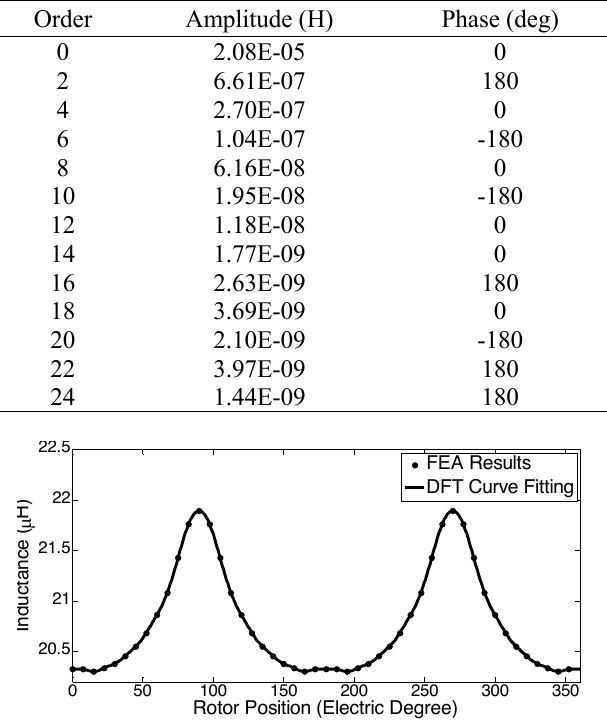
Table 6: Harmonics of Self Inductance of phase 'a' of case study motor